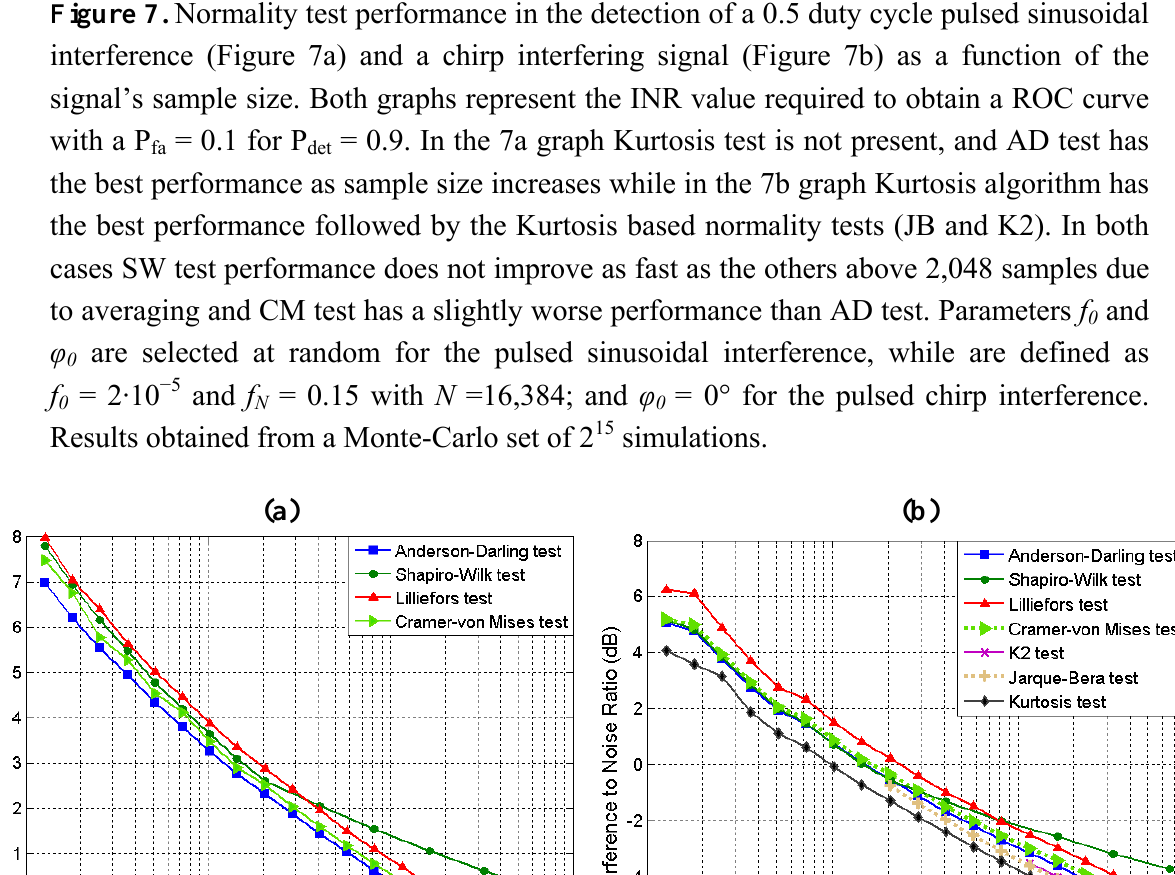
Figure 7. Normality test performance in the detection of a 0.5 duty cycle pulsed sinusoidal interference (Figure 7a) and a chirp interfering signal (Figure 7b) as a function of